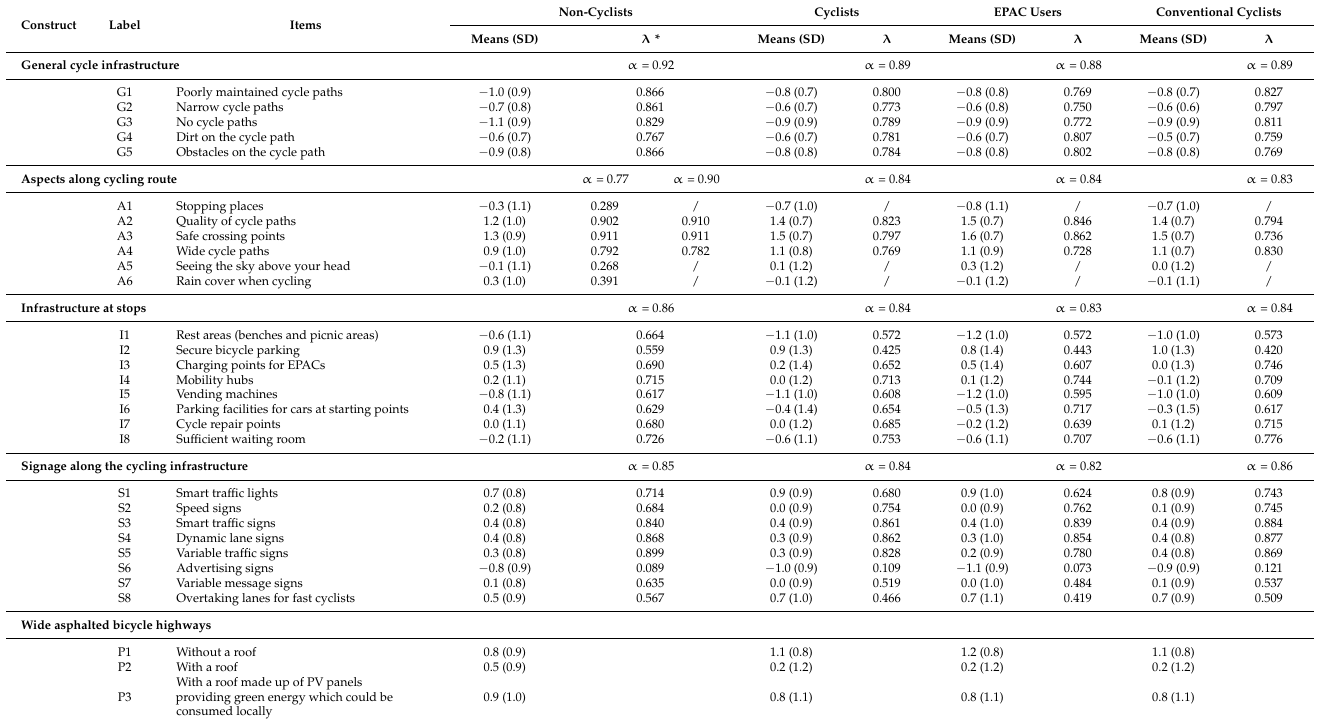
Table 3. Mean, standard deviations and standardized factor loadings ( λ ) of responses on